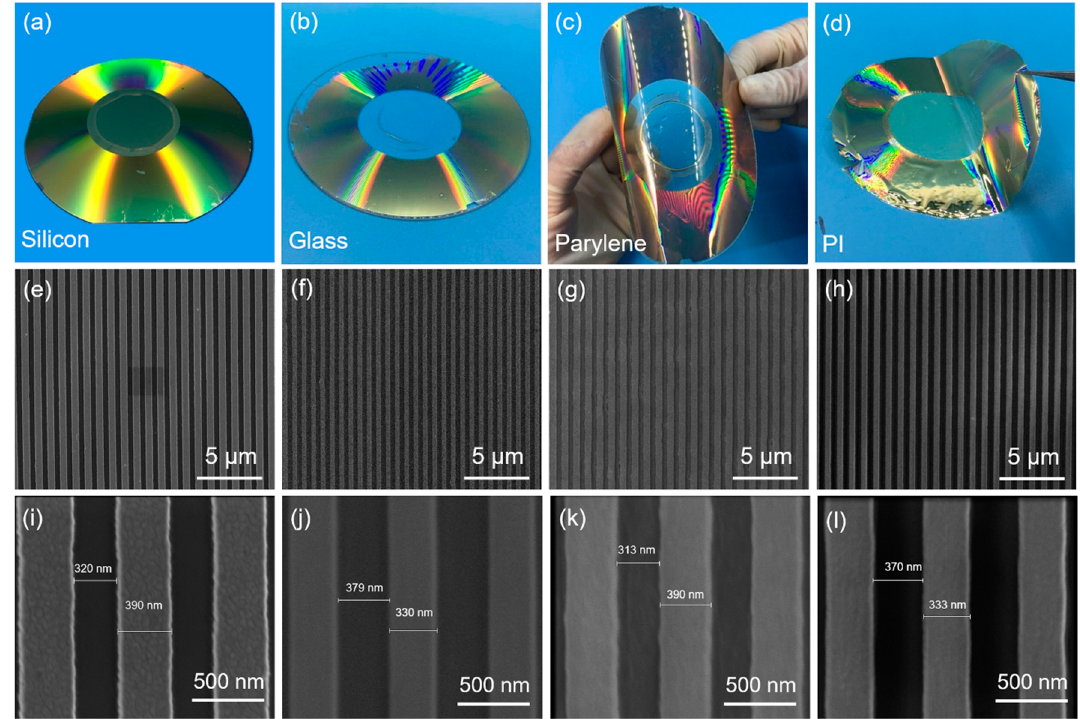
Figure 1. The photographs of gold gratings on different substrates and SEM images with different amplification. The photographs of gold gratings on ( a ) silicon, ( b ) glass, ( c ) parylene-C, and ( d ) PI. SEM images of gold gratings with different amplification on ( e , i ) silicon, ( f , j ) glass, ( g , k ) parylene-C film and ( h , l ) PI.